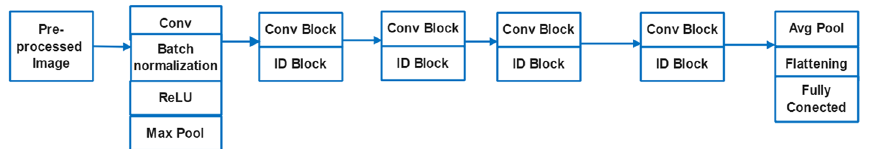
Fig. 4 ResNet50 model in feature